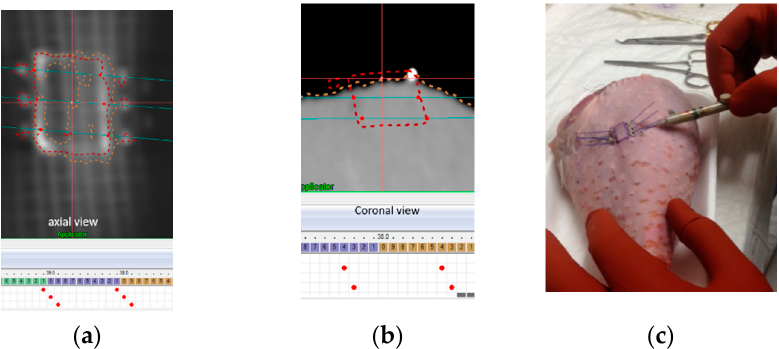
Figure 5. ( a ) CT coronal view of the radio-opaque contouring of the lesion with needles’ insertion and exit points. ( b ) Axial view of the lesion contoured with dotted red line and brachytherapy catheters reconstruction simulating needles displacement. ( c ) Detail of the needle insertion procedure.